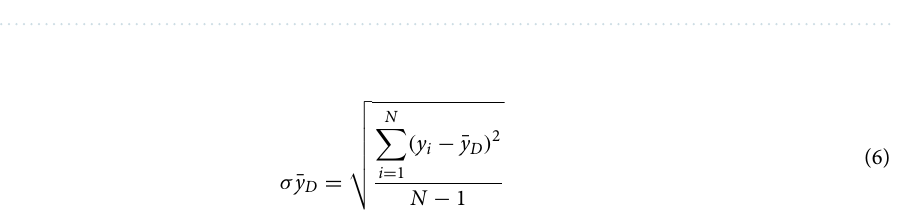
obtained with both systems for four representative